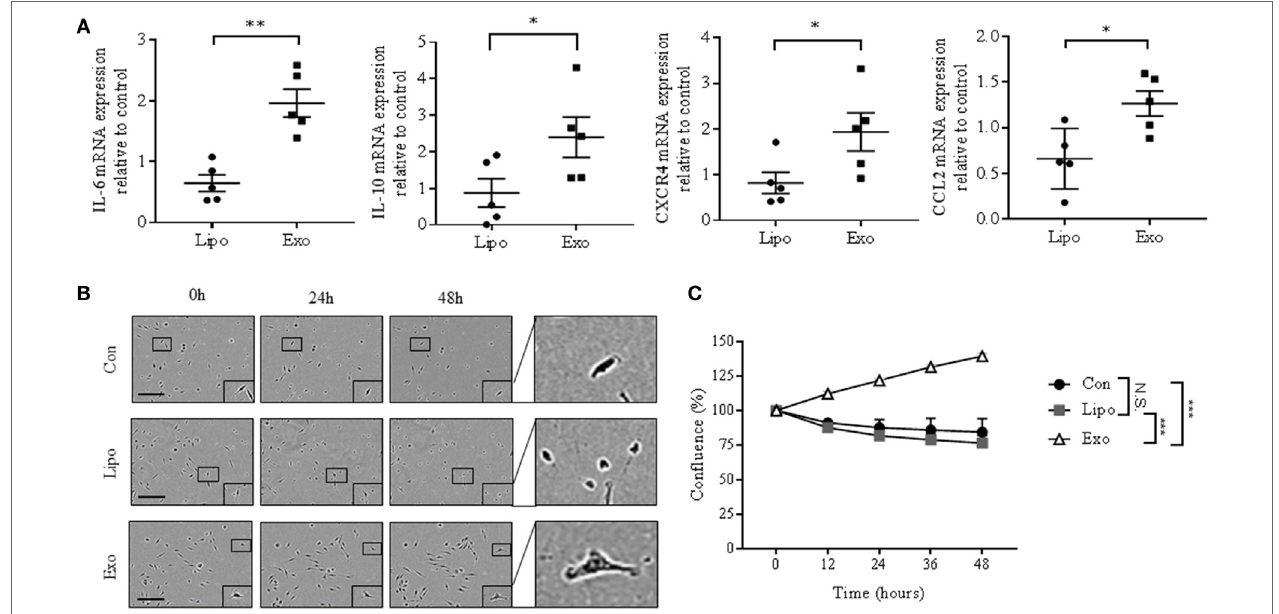
FigUre 3 | EO771-derived exosomes enhance mRNA expression of STAT3 target genes and survival rate of bone marrow-derived macrophages (BMDMs). (a) Interleukin-6 (IL-6), IL-10, CXCR4, and CCL2 mRNA expression was quantified by qRT-PCR in macrophages after liposome or exosome exposure for 24 h. Relative gene expression levels were normalized to GAPDH, and results are shown as relative to PBS-treated BMDMs ( n = 5). * p < 0.05; ** p < 0.01. (B) Incucyte images of macrophages after PBS, liposome, or exosome treatment for 0, 24, and 48 h. The size bar represents 150 µm. (c) Quantitative representation of Incucyte results. Cell confluence was assessed at 5 time points, as an average of 16 images captured per time point. Data were normalized to cell count at 0 h ( n = 3 independent experiments). *** p < 0.001; N.S., not statistically significant, as